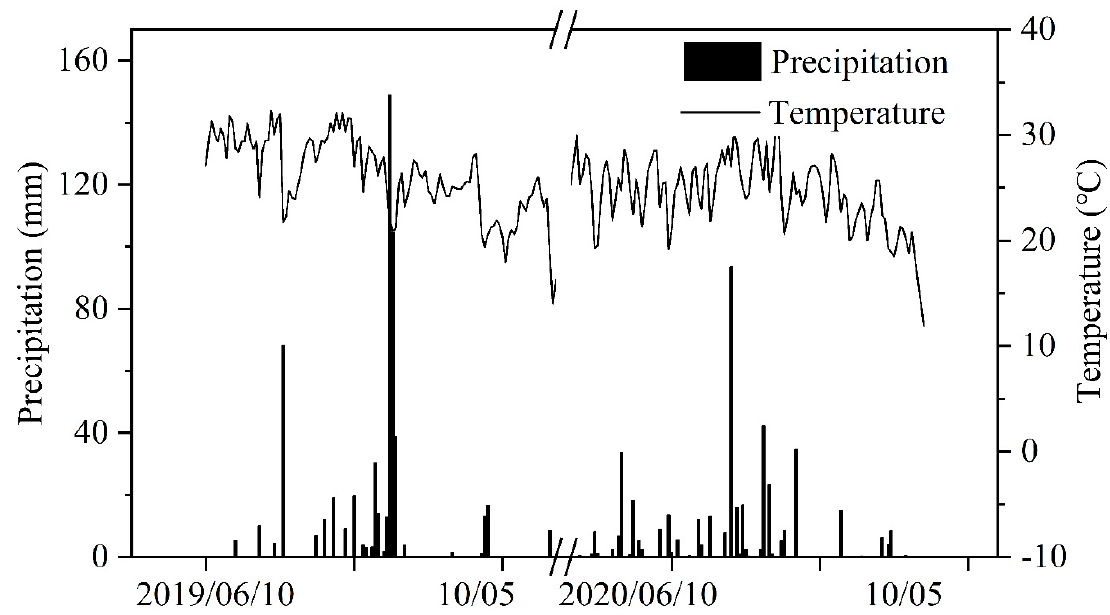
Figure 2. Daily precipitation and mean temperature during the maize growing season in 2019 and 2020.